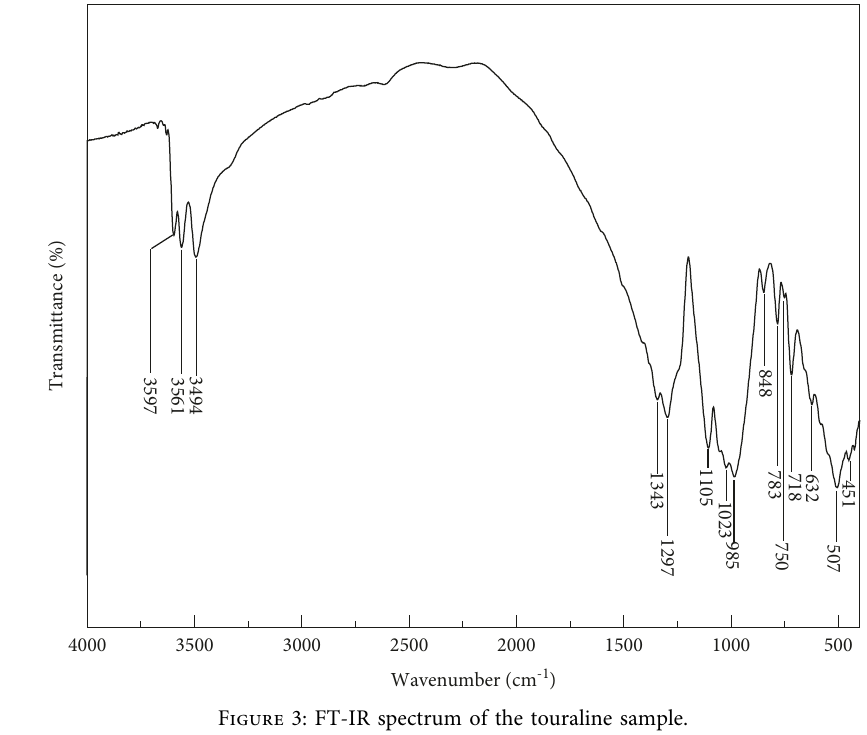
Figure 3: FT-IR spectrum of the touraline sample.